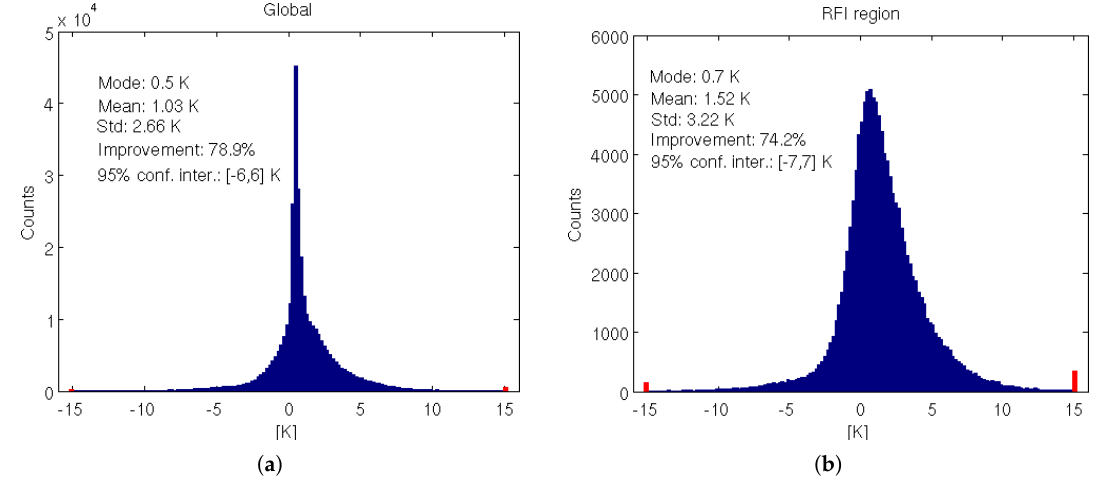
Figure 13. Histograms of the difference between the error standard deviation of SMOS nominal and SMOS NS: ( a ) global map and ( b ) RFI-contaminated region. Those points with error standard deviations higher than 15 K in absolute value are accounted for in the red bars.